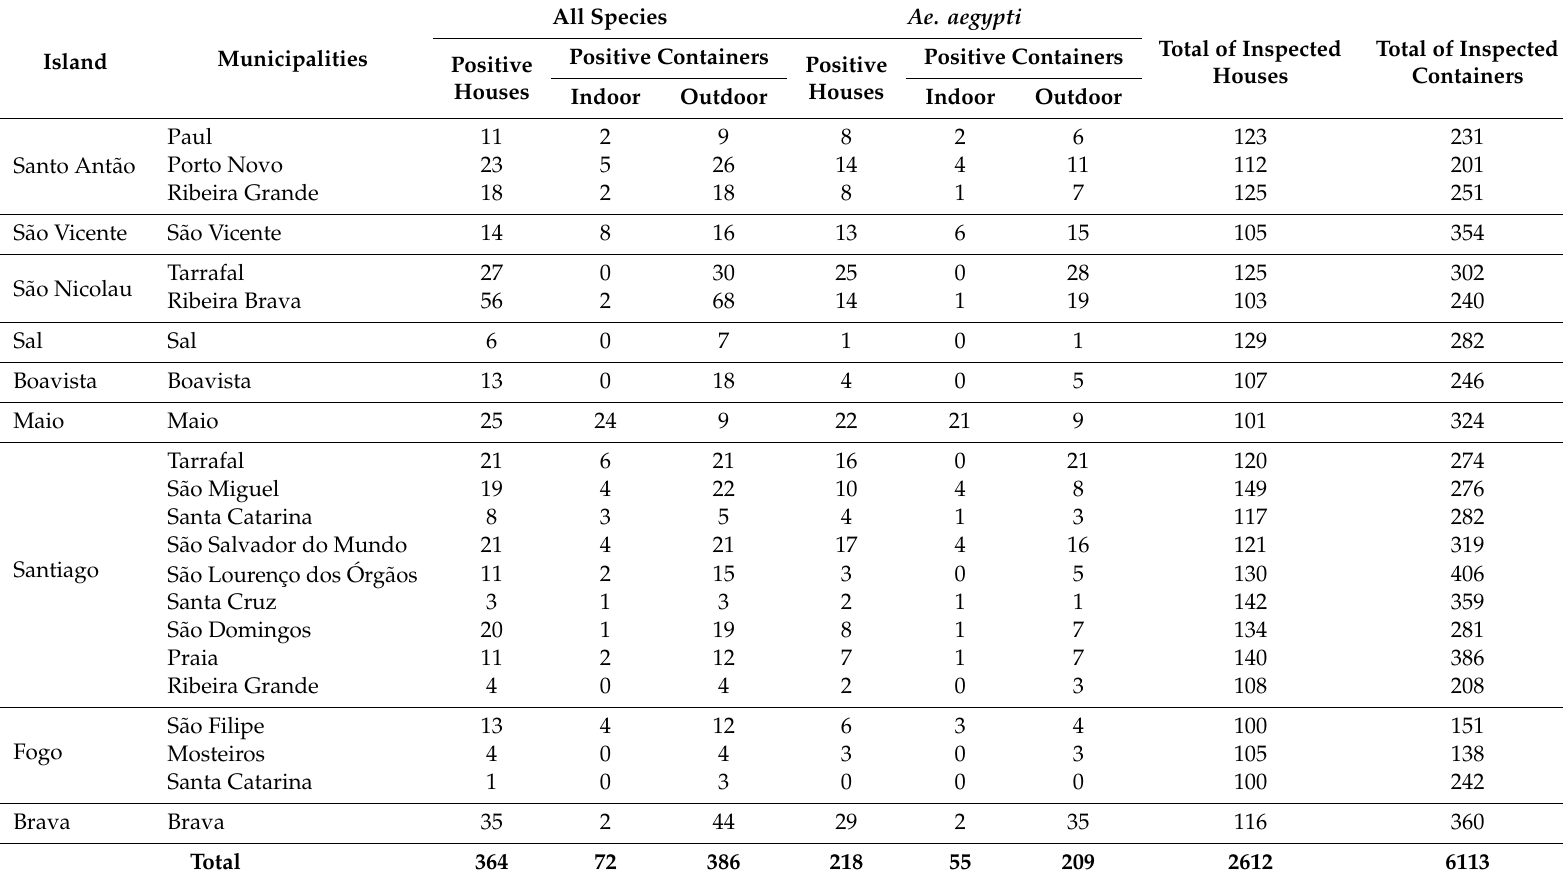
Table 1. Number of houses, inspected containers, its position (indoor / outdoor), and total number of containers with mosquitoes’ larvae.